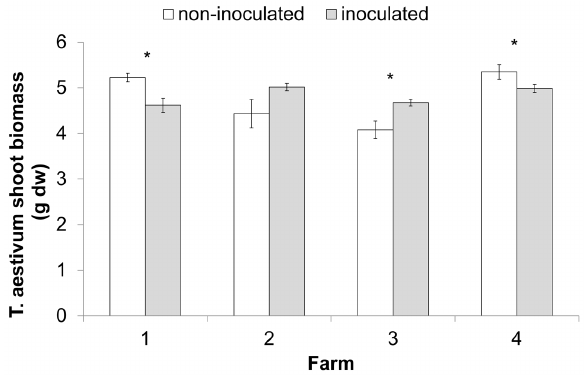
Figure 1. Soil inoculation and plant biomass. Shoot biomass of Triticum aestivum (mean 6 SE) on sterilized soil without inoculum or with 9% field soil inoculum from 4 different farms in the conditioning phase. The asterisks indicate significant differences ( P , 0.05) between non-inoculated and inoculated soil.